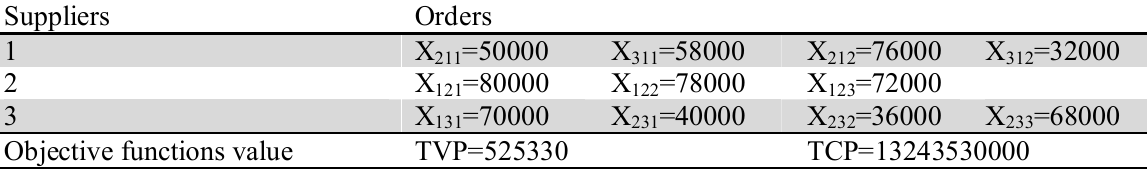
Results of the proposed model